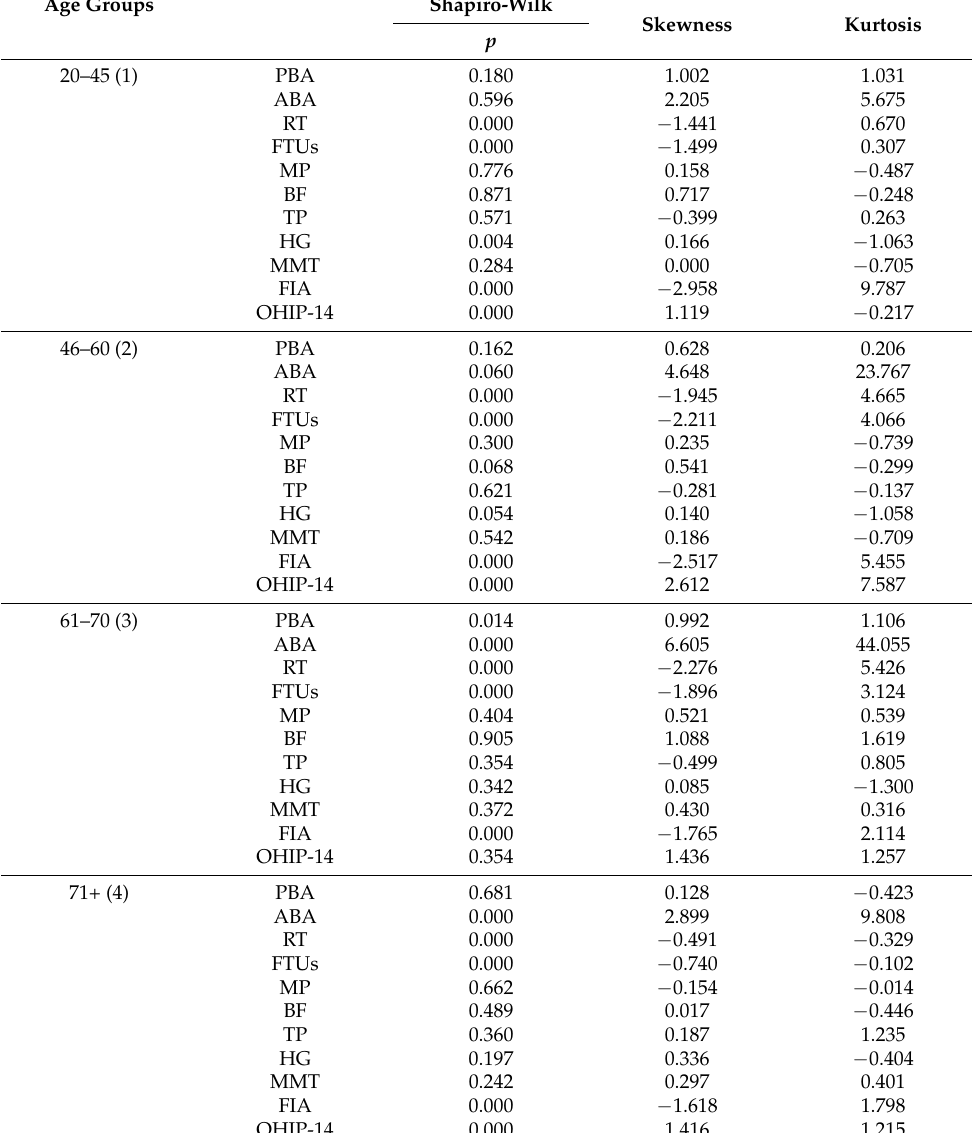
Table A1. The normality tests.